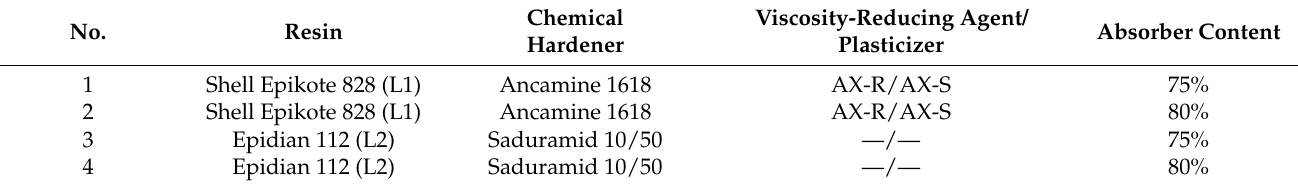
Table 2. List of paint compositions.